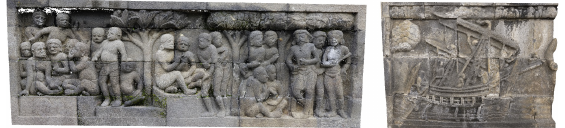
Figure 13. 3D scanned data of reliefs of the Borobudur Temple.